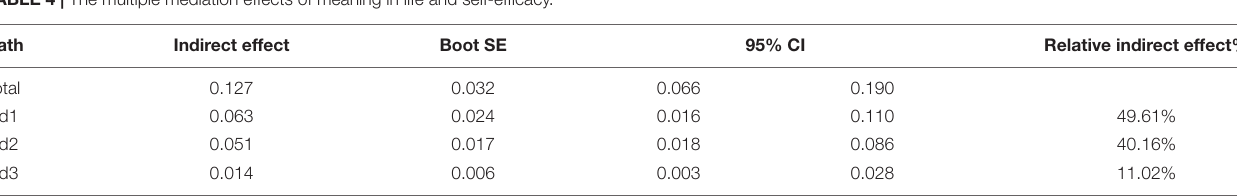
FIGURE 1 | The multiple mediation effect of meaning in life and self-efficacy ( N = 827). a1, a2, a3, b1, b2, c, c’ are standardized coefficients of paths; ∗∗ p < 0.01, ∗∗∗ p < 0.001. TABLE 4 | The multiple mediation effects of meaning in life and